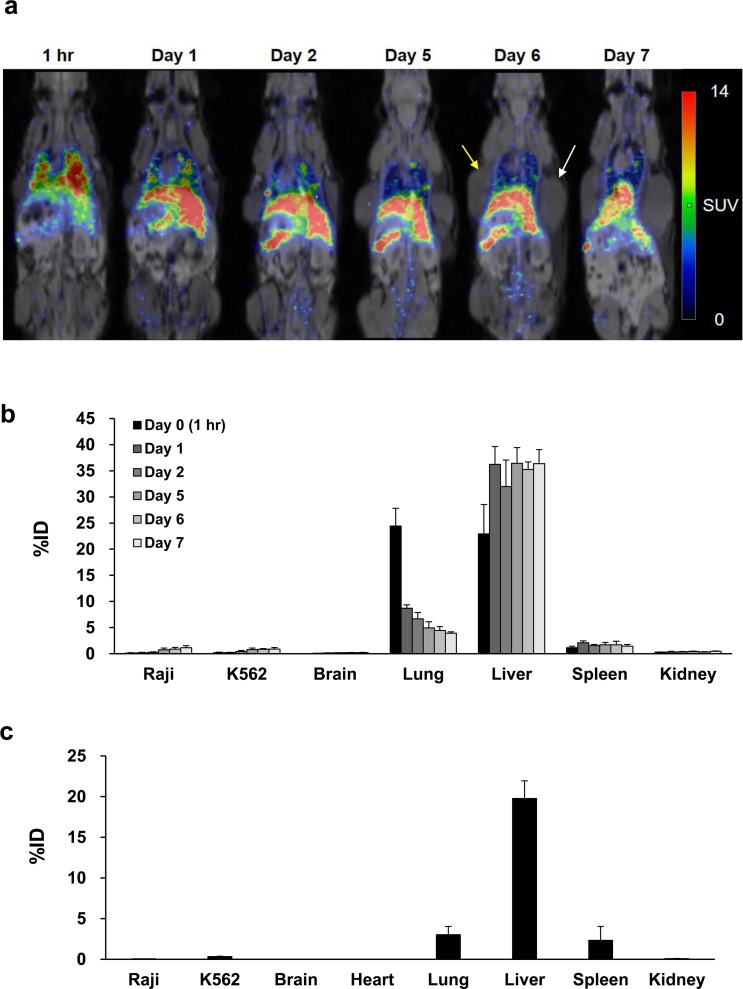
Serial 89Zr-DFO-labeled Jurkat/CAR T-cells animal PET/MR images and analysis of biodistribution.a PET images of the whole-body distribution of intravenously injected 89Zr-DFO-labeled CAR T-cells in NSG mouse xenograft over the following seven days. Yellow arrow and white arrow represent Raji tumor and K562 tumor, respectively. b The in vivo organ distribution of 89Zr-DFO-labeled Jurkat/CAR T-cells measured by PET imaging over the following seven days. c The distribution of ex vivo organ measured by model sacrifice after acquisition of the last PET imaging. (n = 4).